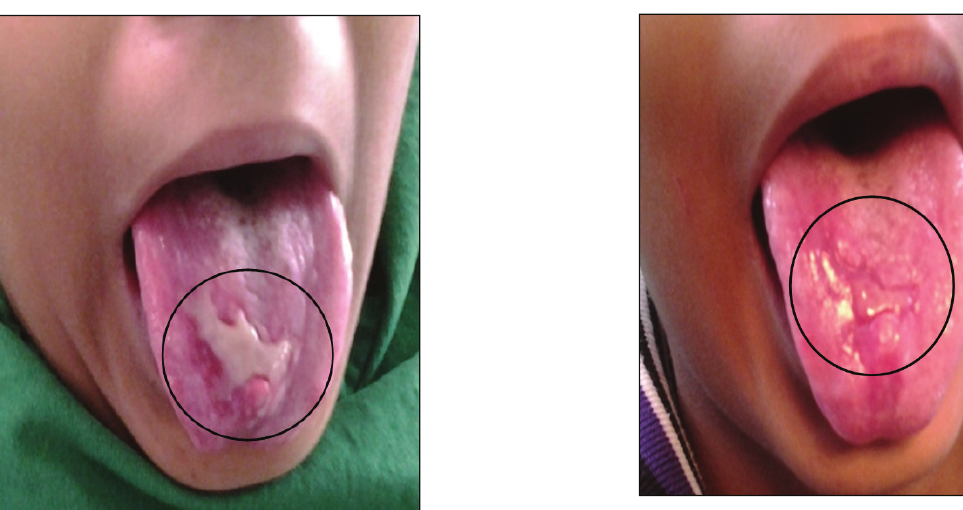
Figure 3: Mid treatment (15th day of treatment) showing reduction in size & healing of the ulceration.